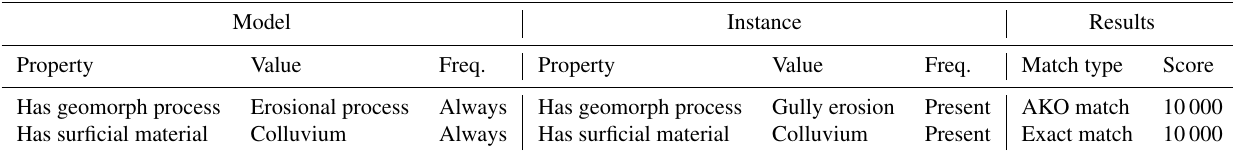
Table 4. Simplified match report table showing instance 117309 compared to the Slides in Soil model. The match report is accessible online by clicking https://spot.italy.minervageohazards.com/match_results?if_id=34434&t_id=117309 (last access: 26 October 2020).